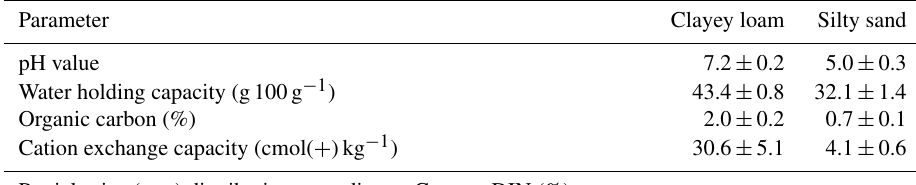
Table 2. Soil characteristics of clayey loam and silty sand (means ± SD). The clay mineral composition of soil samples was determined via X-ray powder diffraction (XRD, Philips X’Pert PW 1830 equipped with a PW2273/20 tube and a theta/theta-goniometer) following Poppe et al. (2016). Values were not corrected for reference intensity ratios (RIR). Alternating strata can occur for illite, smectite, or vermiculite. X-ray fluorescence (XRF) characterization of the chemical composition (in % w/w ) was performed using an Axios spectrometer (PANalytical, EA Almelo, the Netherlands). Loss of ignition was 12.8 for the clayey loam and 1.3 for the silty